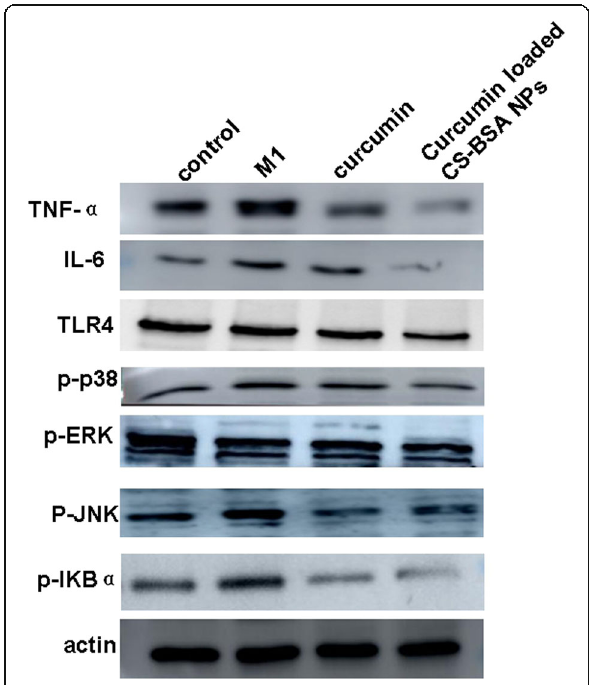
Fig. 6 Western blot analyses of the expression levels of TNF- α , IL-6, TLR4, and phosphorylation of ERK, JNK, p38, and nuclear factor (NF)- κ B in RAW 264.7 cells (M1 phenotype) after treatments with free curcumin and curcumin loaded CS-BSA